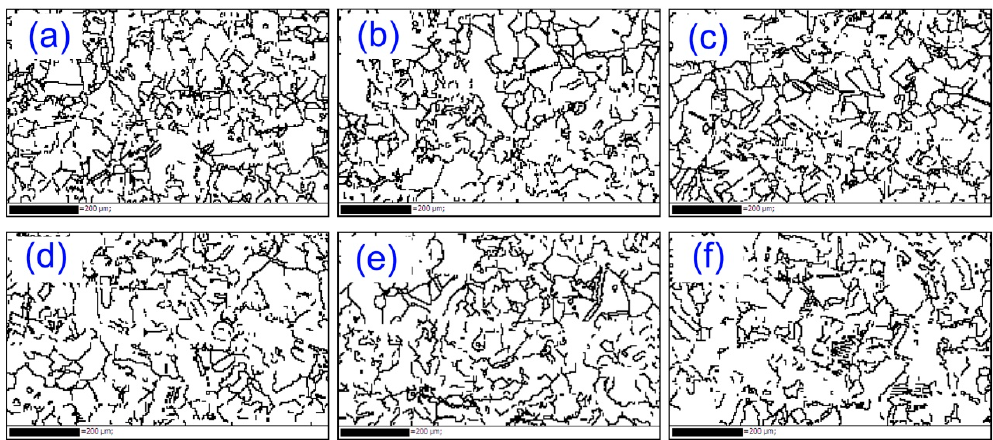
Figure 13. Networks of misorientation angles >15° for the repeated welding specimens using EBSD: ( a ) AW; ( b ) RW1; ( c ) RW2; ( d ) RW3; ( e ) RW4; and ( f ) RW5.